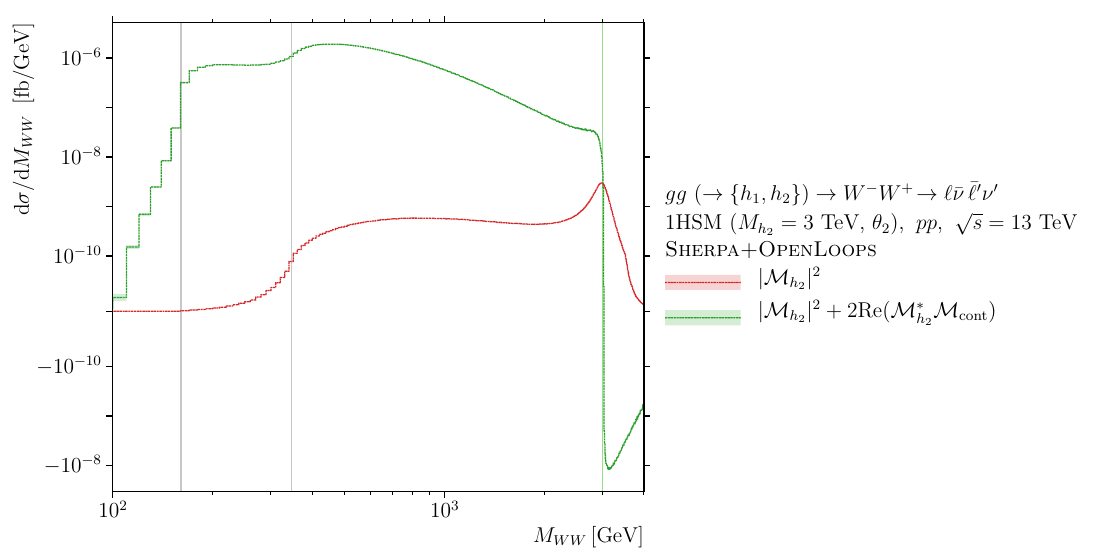
Figure 1 . M WW distribution of the heavy Higgs cross section and including its interference with the continuum background in the 1-Higgs-Singlet Extension of the SM (1HSM) with M h and mixing angle θ 2 (see table 1) for gg ( √ s = 13 TeV. For details, see sections 2 and